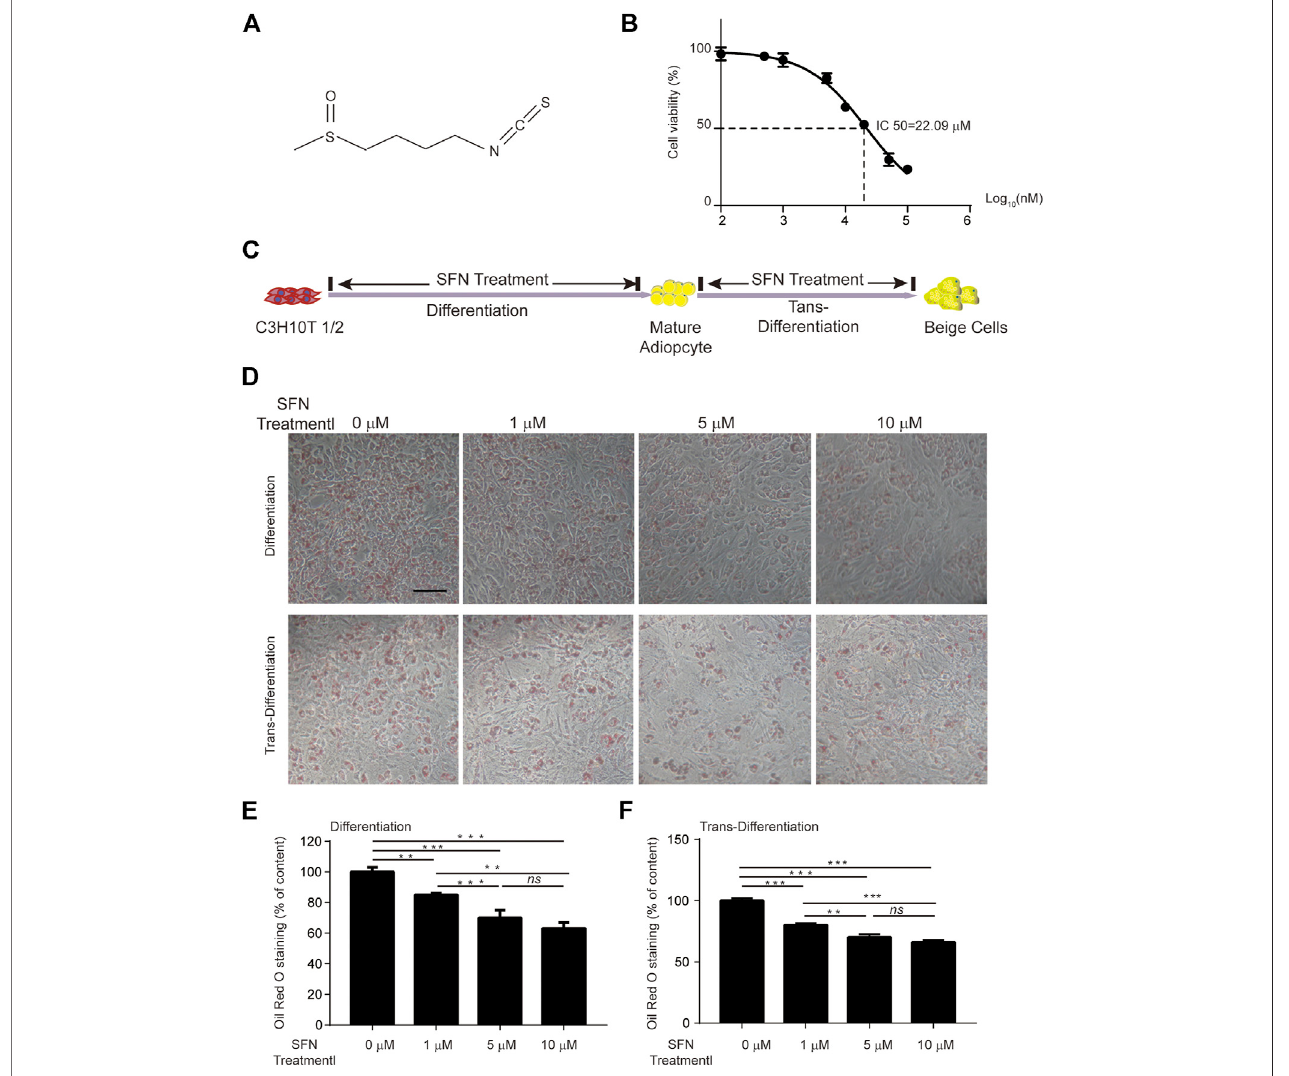
FIGURE 1 | Effects of SFN on lipid droplet biogenesis during the differentiation o r trans-differentiation of C3H10T1/2 cells. (A) Chemical structure ofSFN. (B) IC50 ofSFNonC3H10T1/2cells. (C) Flowdiagramoftheexperimentaldesign (D) SFNinhibitedthelipidaccumulationinthedifferentiationofC3H10T1/2cellsandenhanced thetrans-differentiationofadipocytes.Cellswere fi xedandstainedwithOilredO. (E,F) OilredOstainingwasquanti fi ed.Scarbar (cid:2) 50 μ m.Alltheresultswereexpressed in graph with mean ± SD. Statistical signi fi cance was evaluated by ANOVA test. *, ** and *** represent the signi fi cant difference at p < 0.05, p < 0.001 and p < 0.0001. ns represent not signi fi